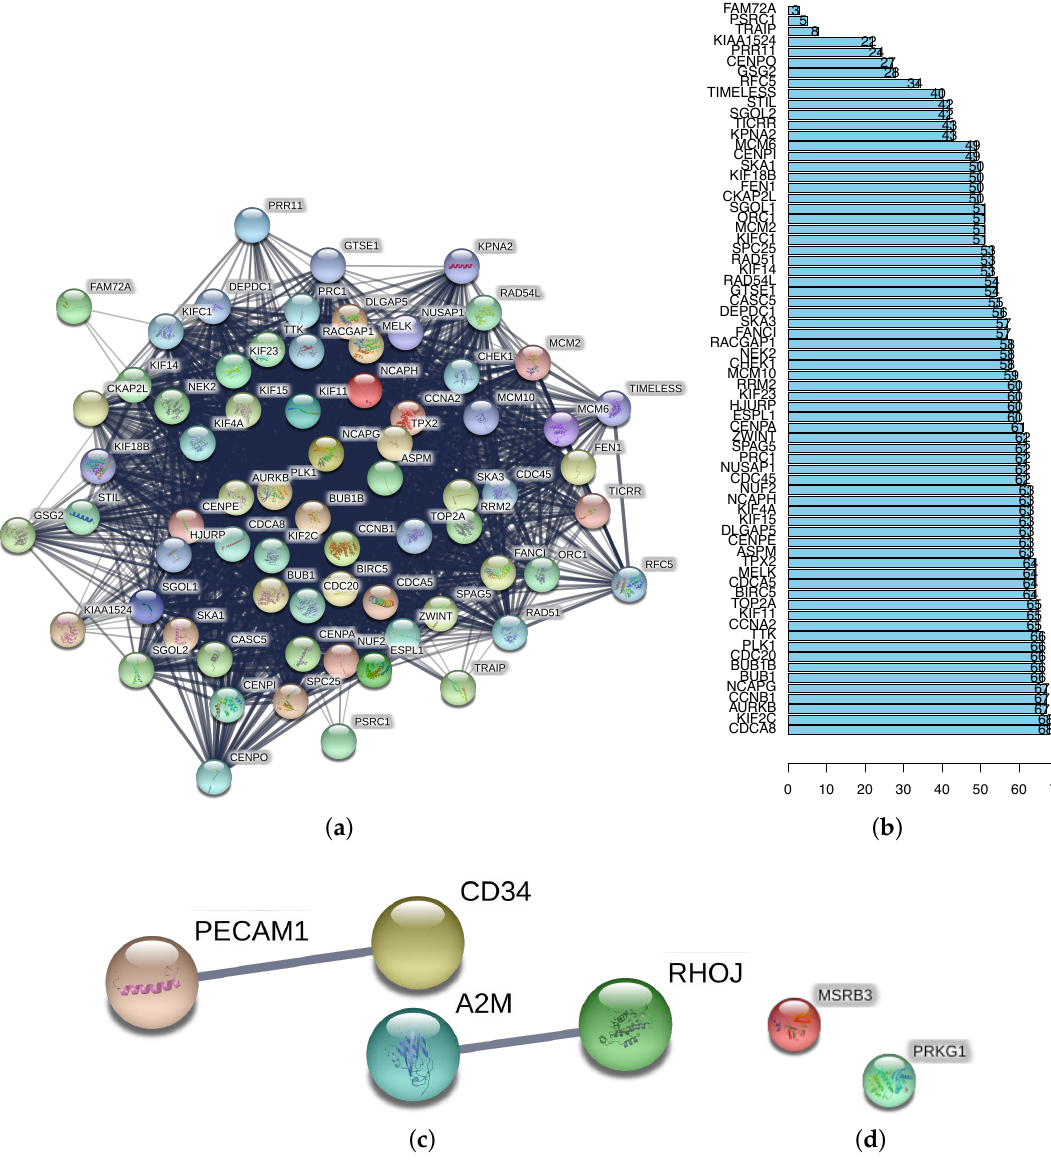
Figure 6. ( a , c , d ) PPI networks were drawn using the online tool STRING (URL: https://string-db.org/), for the key proteins from the blue, brown, and purple modules. We set the minimum required interaction score as medium confidence (0.4) and hid disconnected nodes in the network. ( b ) As the blue module had the most distinguished scale, we profiled a bar-plot to list its key genes by the counts of